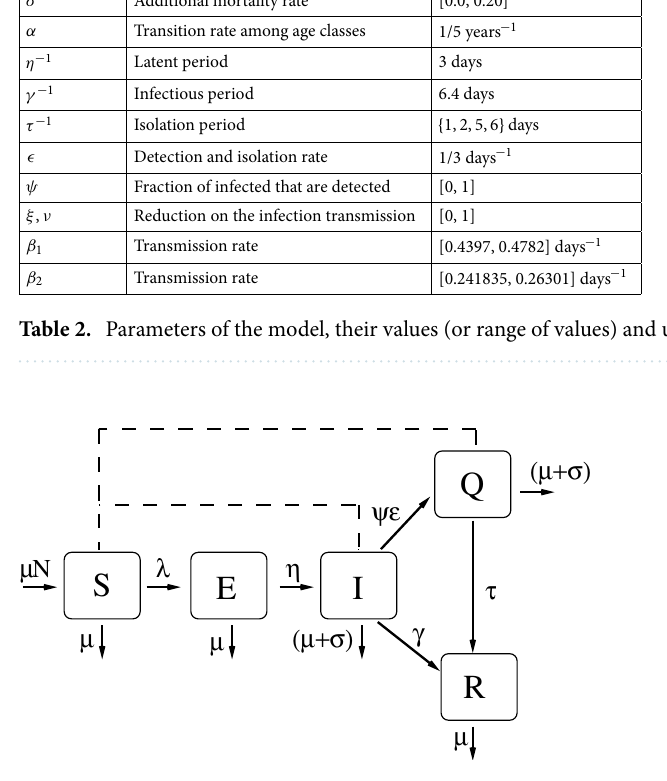
Figure 9. The variables of the model are susceptible ( S ), exposed ( E ), infected( I ), isolated ( Q ) and recovered individuals ( R ). The continuous line indicates transitions between compartments and the dashed line indicates interactions between compartments that contributes to the infection force, (cid:31) . The model’s parameters are described at Table